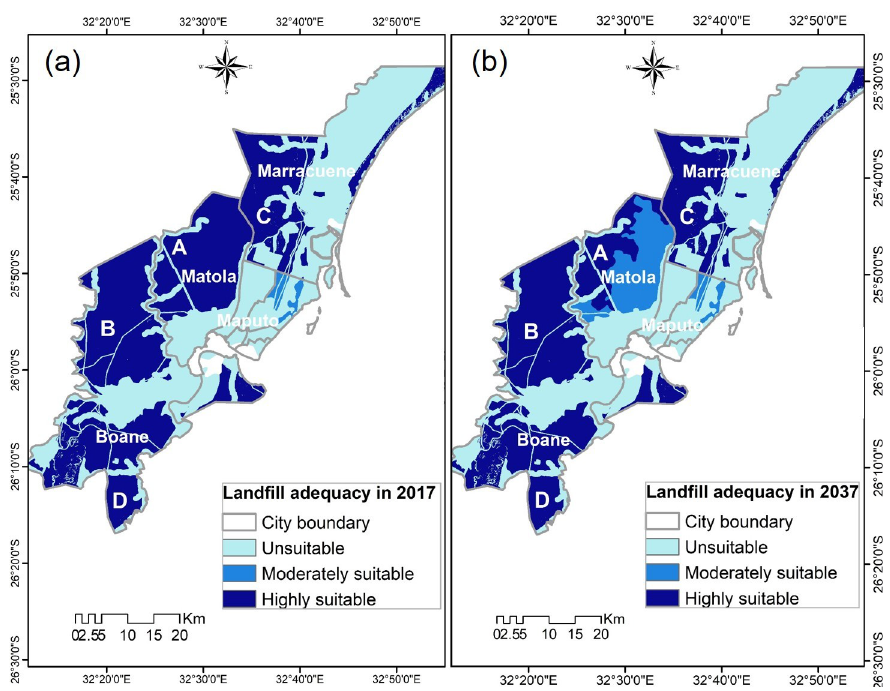
Fig 7. Final suitable maps. (a) Scenario 1 –weighted overlay for 2017; (b) Scenario 2 –weighted overlay for 2037. Maps were edited from the Landsat [45] and USGS EROS [46].